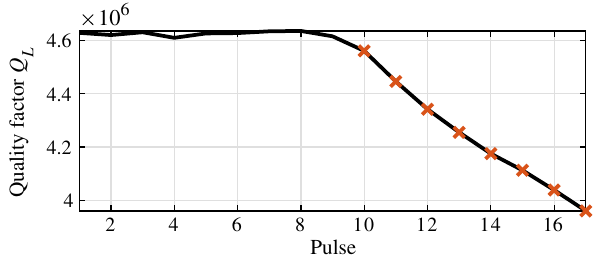
FIG. 11. Loaded quality factor Q L .